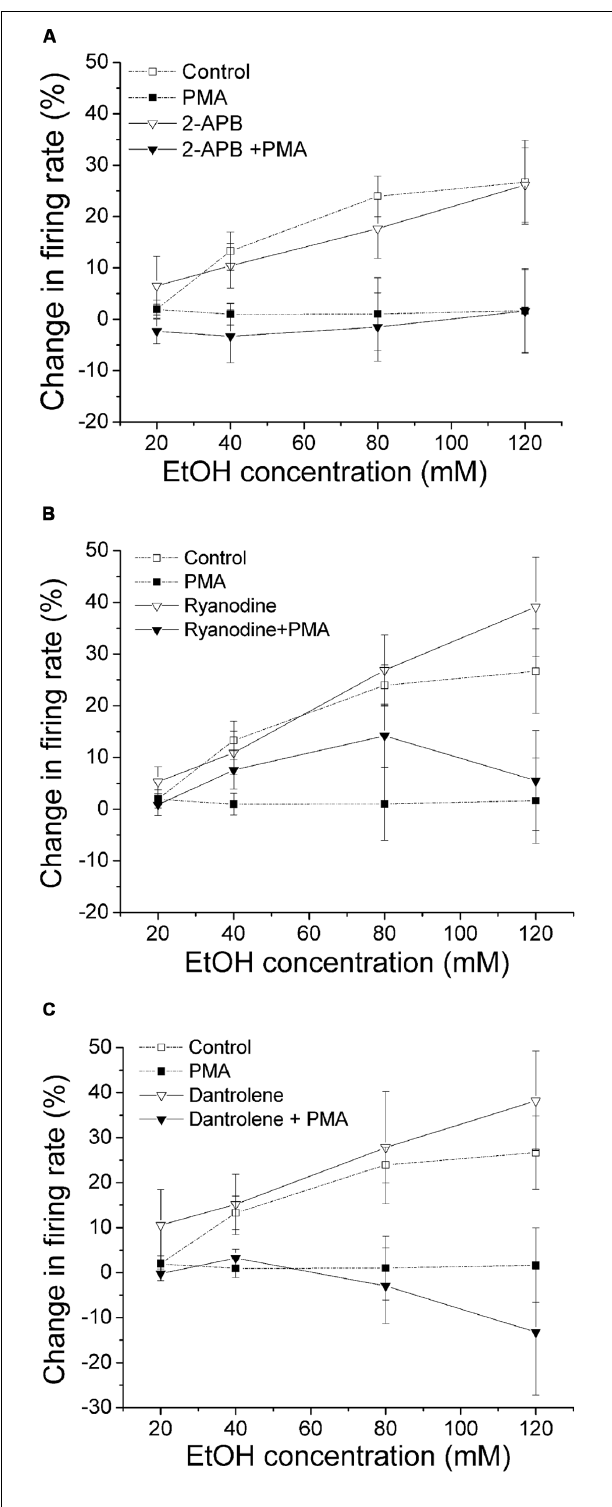
FIGURE 5 | Inhibition of calcium release from the intracellular stores does not alter PMA suppression of ethanol-induced excitation. Percentage change in firing rate (mean ± SEM) in response to ethanol application in different conditions is plotted as a function of time.The